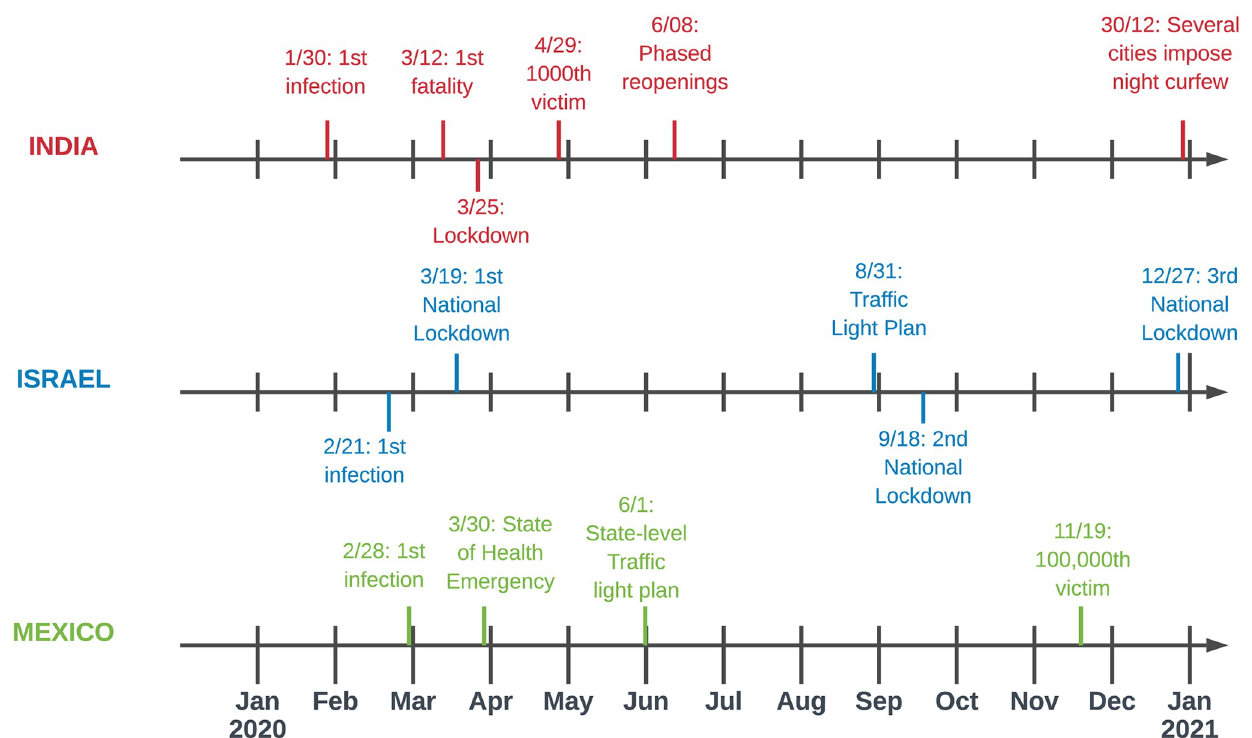
Fig 1. Timeline of main COVID-19-related events in India, Israel and Mexico (January 2020-December 2020).